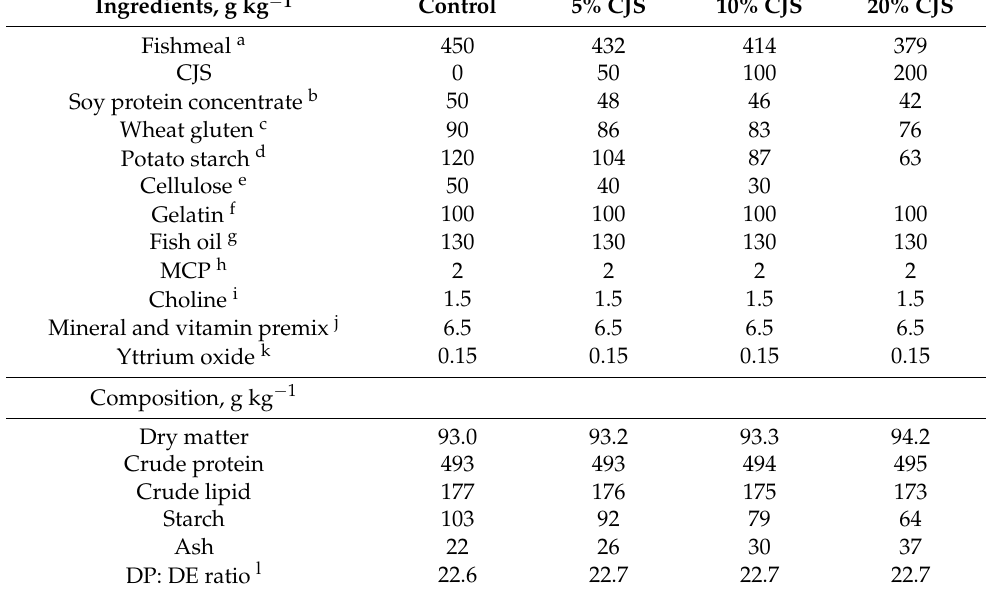
Table 2. Diet formulation and calculated chemical composition of the diets used in the retention experiment with Atlantic salmon ( Salmo salar ): a fishmeal control (FM), and three diets with increasing levels of Cyberlindnera jadinii